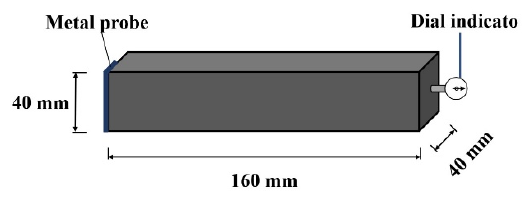
Figure 3. The measurement of dry shrinkage rate.